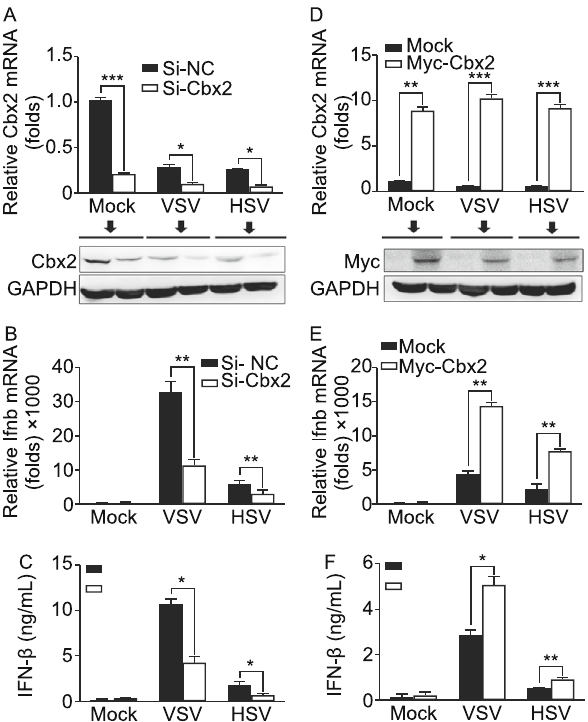
Figure 2. Cbx2 promotes virus-induced type I interferon production in macrophages. Q-PCR (upper panel) and Western blot (lower panel) of Cbx2 expression in mouse peritoneal macrophages. (B and C) Analysis of the level of IFN- β mRNA (B) and protein (C) in peritoneal macrophages with Cbx2 knockdown by Q-PCR and ELISA. Cells were transfected with a control siRNA (Si-NC) or a Cbx2-targeting siRNA (Si- Cbx2) for 48 h, and then infected with virus (MOI = 10) for 8 h (A – C). (D) Q-PCR (upper panel) and Western blot (lower panel) analysis showing effective overexpression of Cbx2 in Cbx2 stably over-expressing (Myc-Cbx2) RAW264.7 cells. (E and F) Q-PCR (E) and ELISA (F) analysis of virus-induced IFN- β in Mock or Myc-Cbx2 RAW264.7 cells infected with virus (MOI = 10) for 8 h. Cbx2 and IFN- β mRNA values were normalized to the expression of β -actin and all data are from three indepen- dent experiments (mean ± SEM of technical triplicates). Data are representative of three independent experiments with